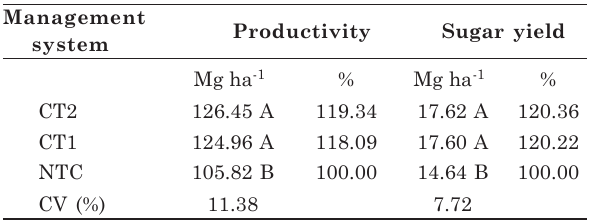
Table 5. Sugarcane productivity and sugar yield under managements with traffic control with adjusted track width and use of an autopilot (TC2) and only adjusted track width (TC1) and with no traffic control (NTC)